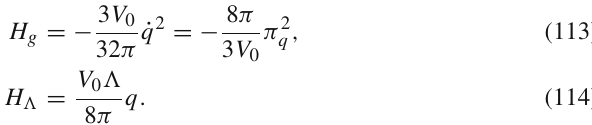
Fig. 26 Variations in the quantum fluctuation versus the coherence. The horizontal axis represents the coherence. The parameters are taken as: α = 1, V 0 = 1, A 0 = 1, mN m = 10